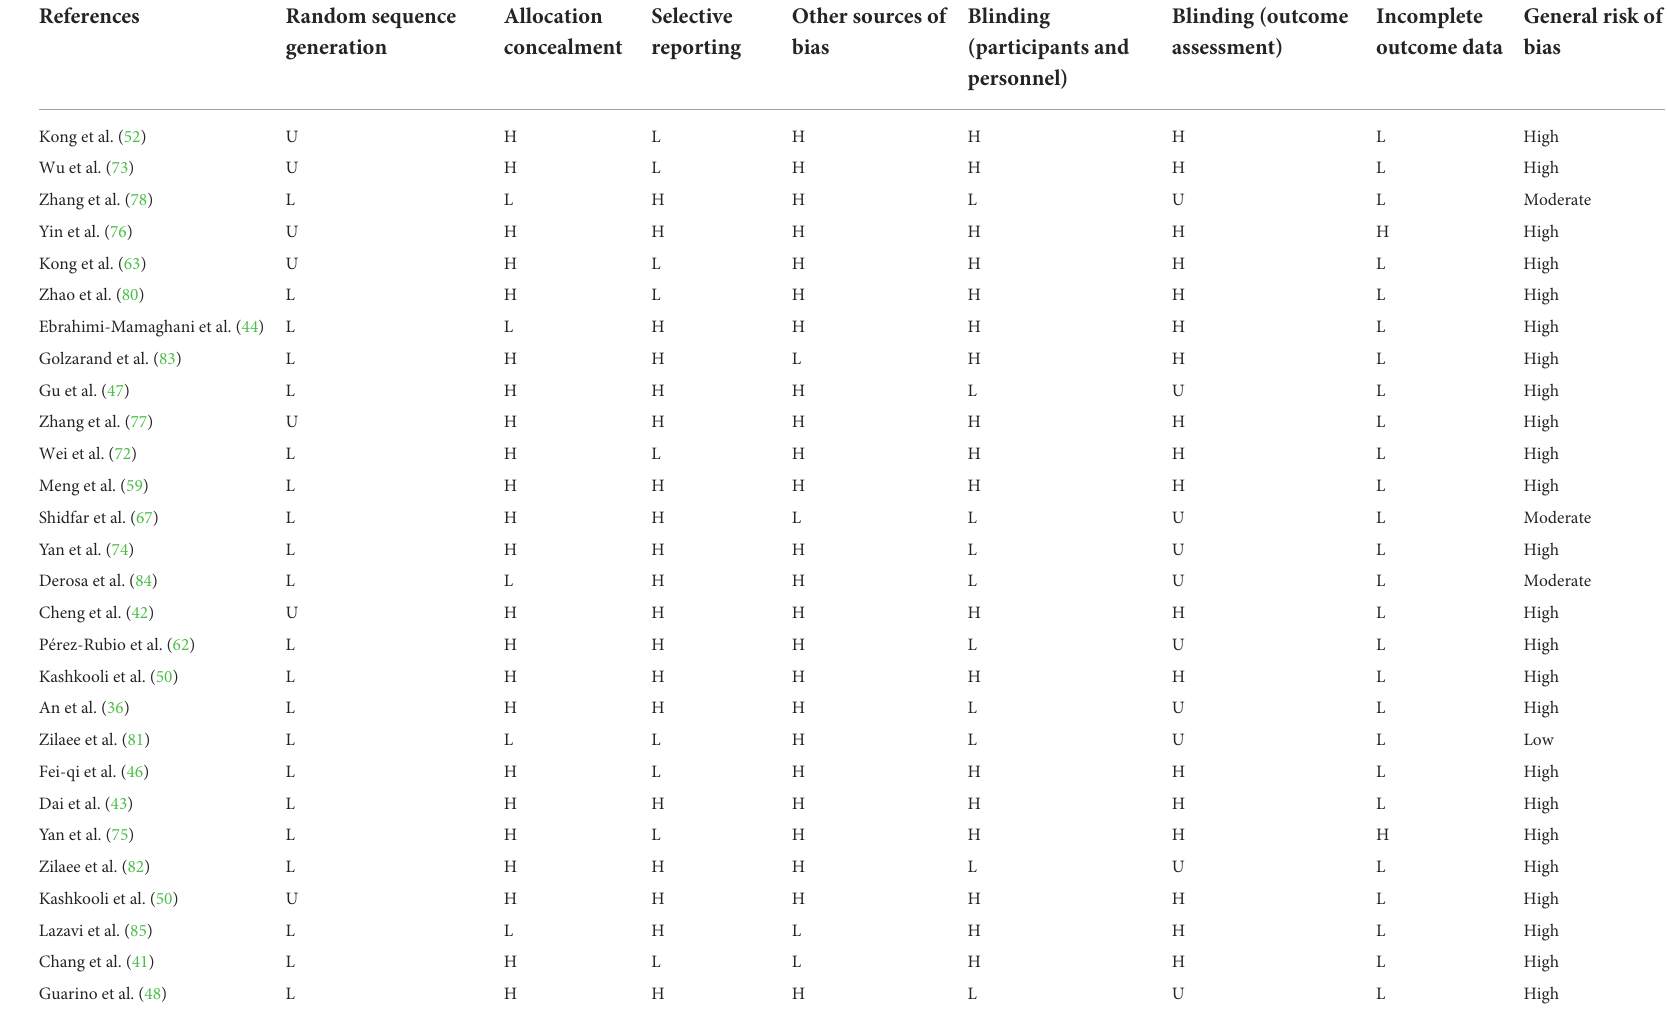
TABLE 2 Risk of bias